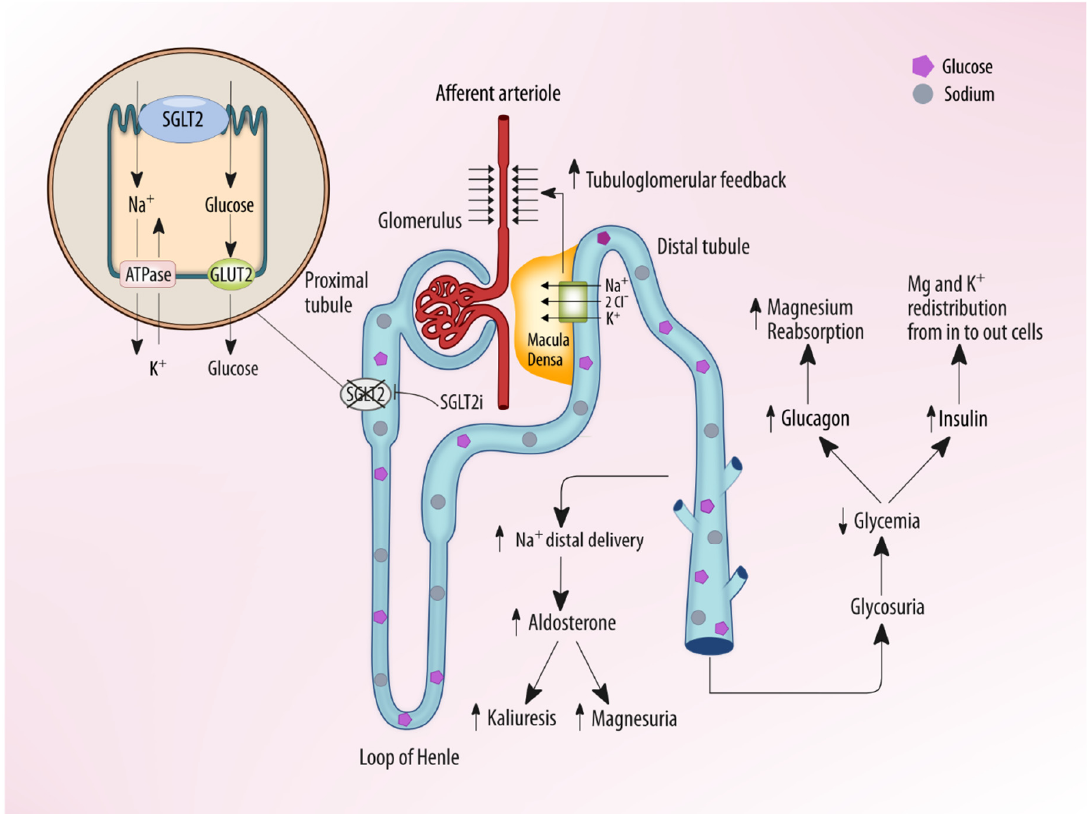
Figure 4. Effects of SGLT2i on serum electrolytes: SGLT2 inhibition promotes glycosuria, natriuresis, and osmotic diuresis, determining enhanced aldosterone activity with increased kaliuresis and magnesuria. Such effects are counterbalanced by an improvement in glycemic control with an elevation of serum glucagon and reduction of insulin, which favors redistribution of potassium and magnesium in cells from the intracellular space. The final effect is a potential low increase of serum potassium and magnesium levels.